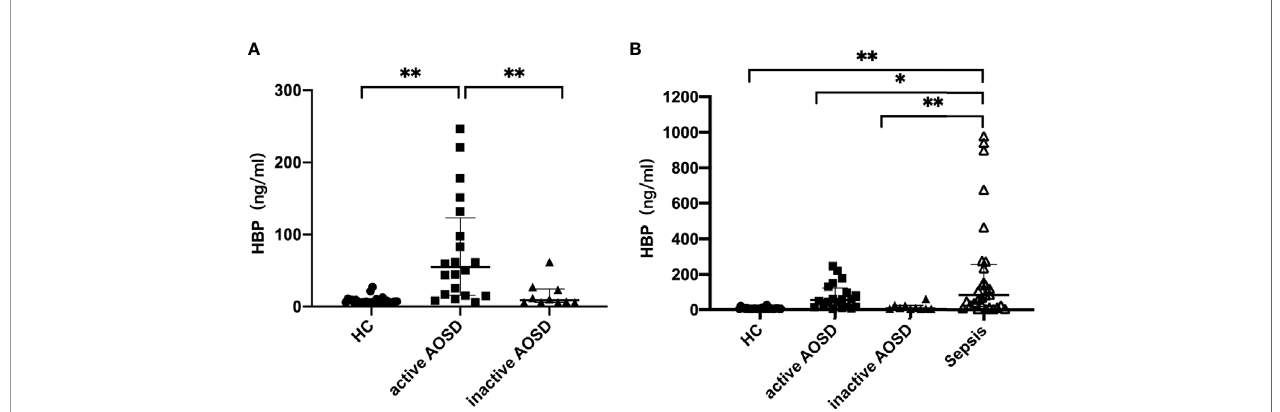
FIGURE 1 | Comparative analysis of HBP in patients with active AOSD patients, inactive AOSD patients, healthy controls (A) and Sepsis (B) . Concentrations of HBP in serum form HC (healthy controls, fi lled circles), active AOSD patients ( fi lled squares), inactive AOSD patients ( fi lled triangles) and Sepsis patients (inversed hollow triangles). Data are presented as mean with standard deviation (SD). * P < 0.05, ** P <